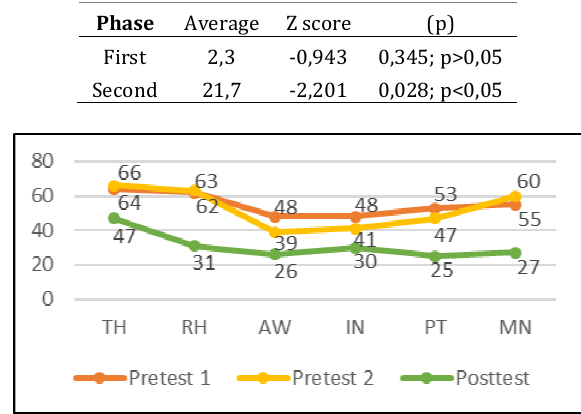
Fig. 3 Psychological burden scores each